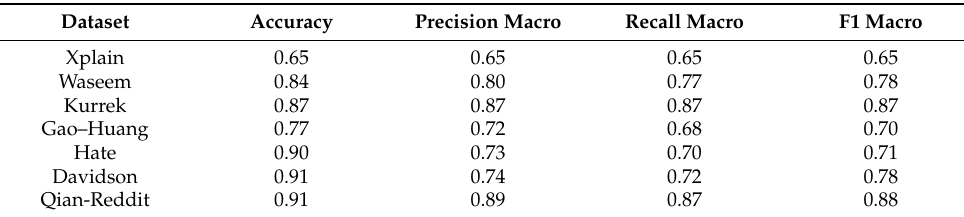
Table A5. Scores obtained on the benchmark Datasets using the GloVe embeddings with 2 LSTM layers and max pooling.